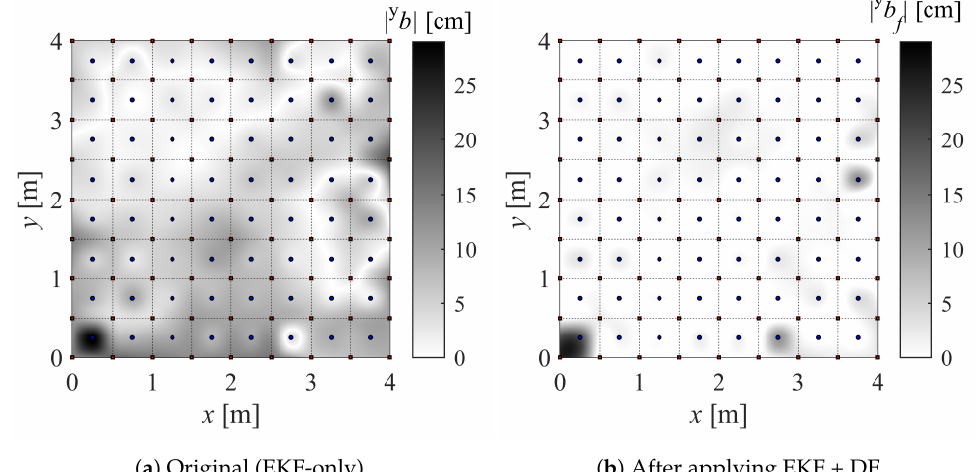
Figure 15. Absolute bias for x -direction measurements.